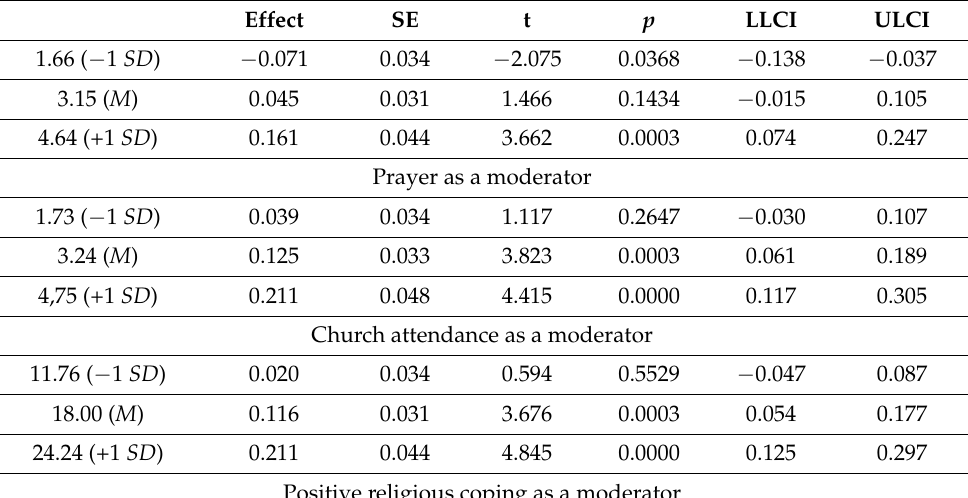
Table 5. Conditional effects of hope at values of moderators.